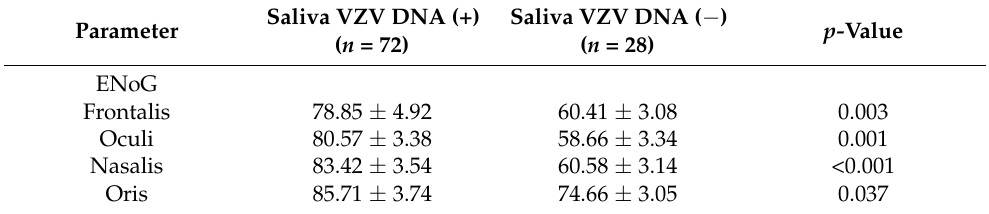
Table 5. Differences between ENoG values measured in four facial muscles of VZV DNA-positive and negative